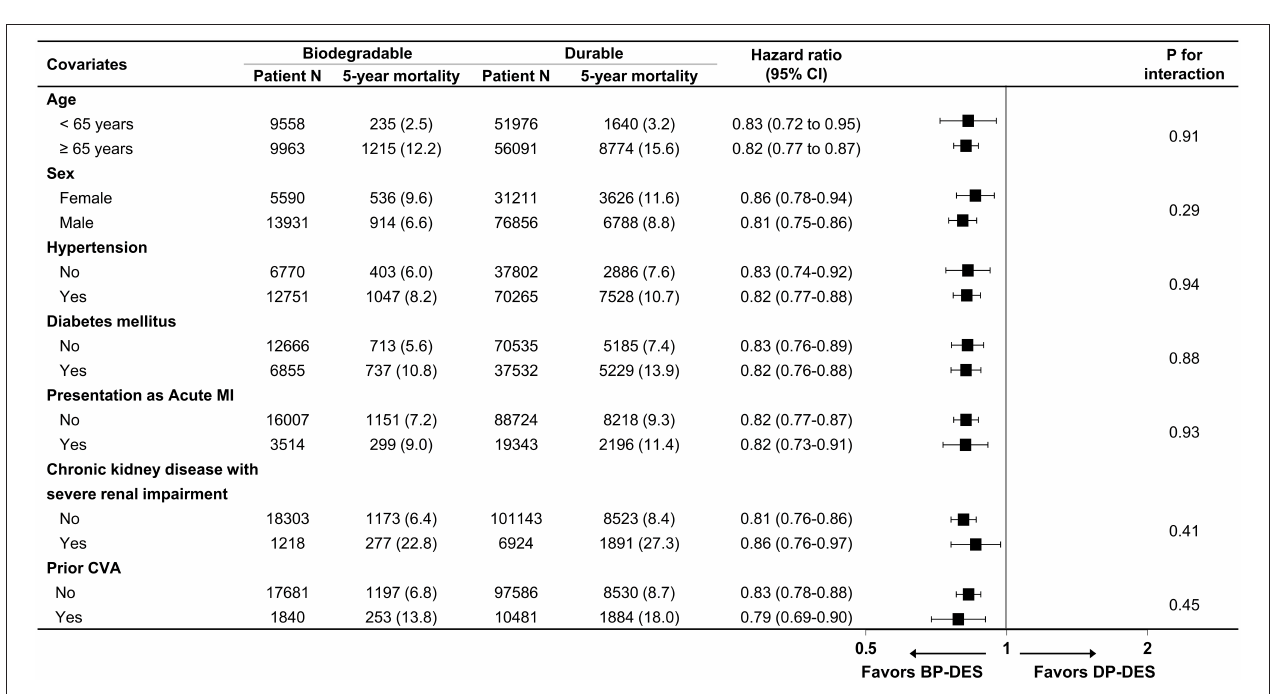
FIGURE 4 | Subgroup analyses for cardiovascular death. Numbers and percentages show the number of patients at risk, those who died with cardiovascular disease, and the cardiovascular mortality rate at 5 years after drug-eluting stent implantation. CI, confidence interval; CVA, cerebrovascular accidents; BP-DES, biodegradable polymer drug-eluting stent; DP-DES, durable polymer drug-eluting stent; MI, myocardial infarction.